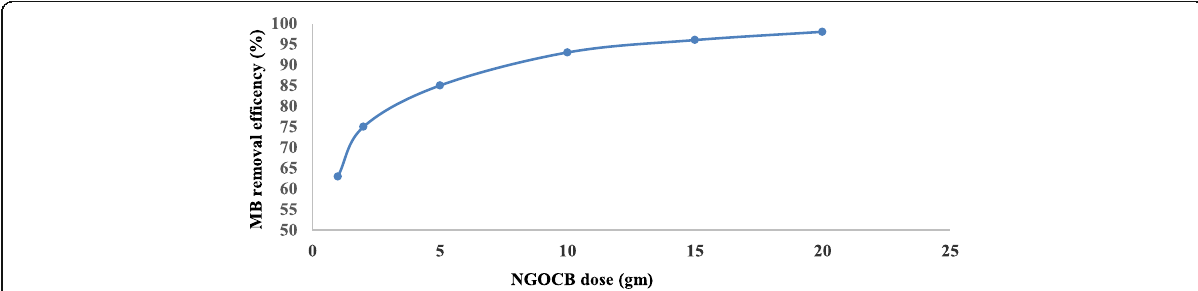
Fig. 8 Effect of NGOCB dose on the removal efficiency of methylene blue (pH 7, stirring time 15 min, room temperature, stirring rate 150